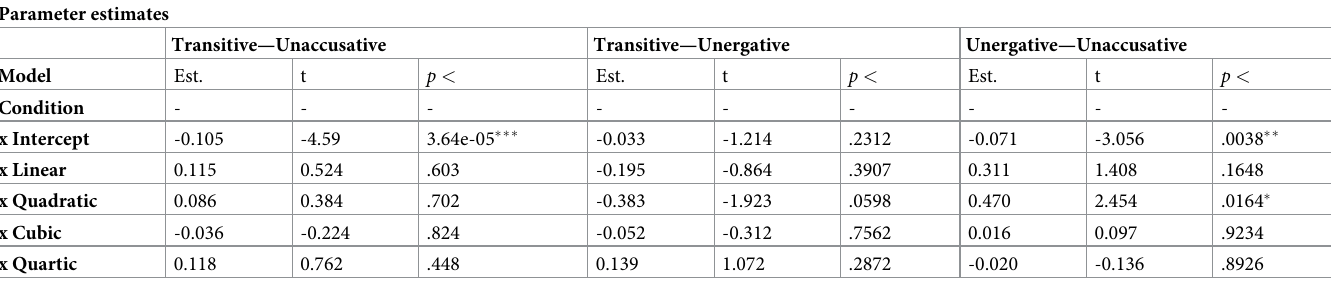
Table 8. Pairwise comparisons of the models of the curves in the global post-verbal frame.